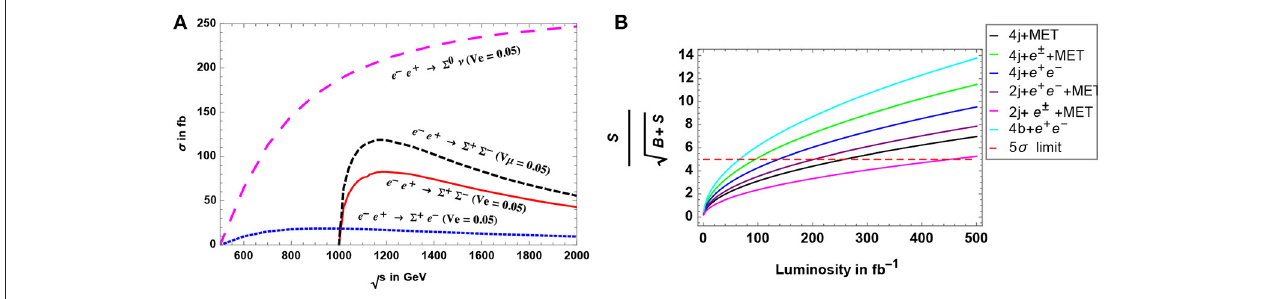
6 0 ν , 6 ± e ∓ , 6 + 6 − as a function of the center of mass energy for e + e − colliders, with M 6 →